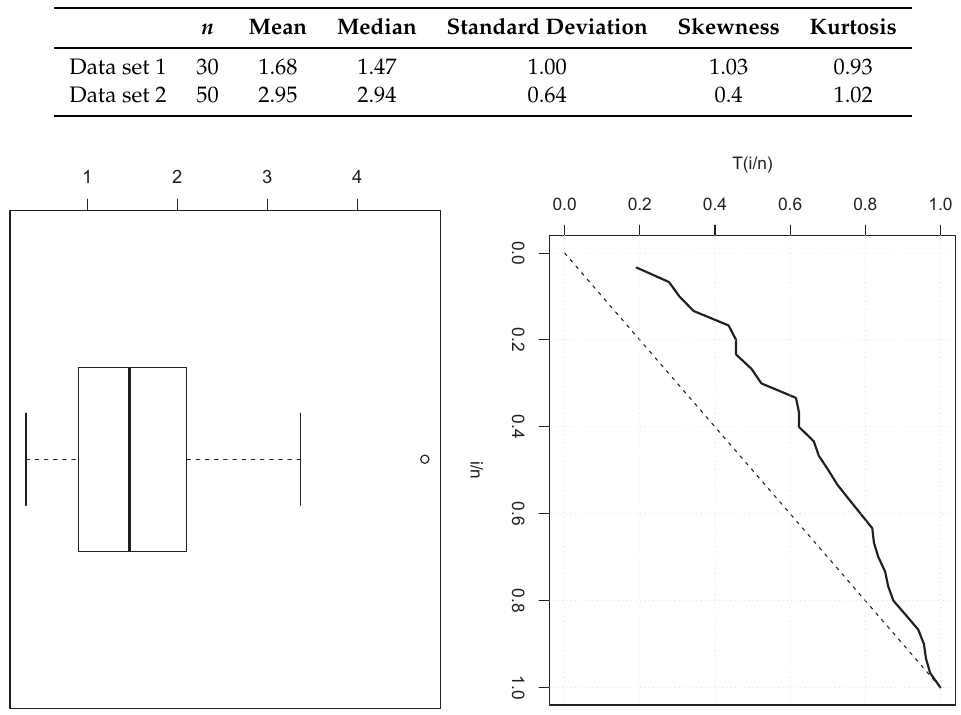
Table 6. Descriptive statistics for data sets 1 and 2, respectively.